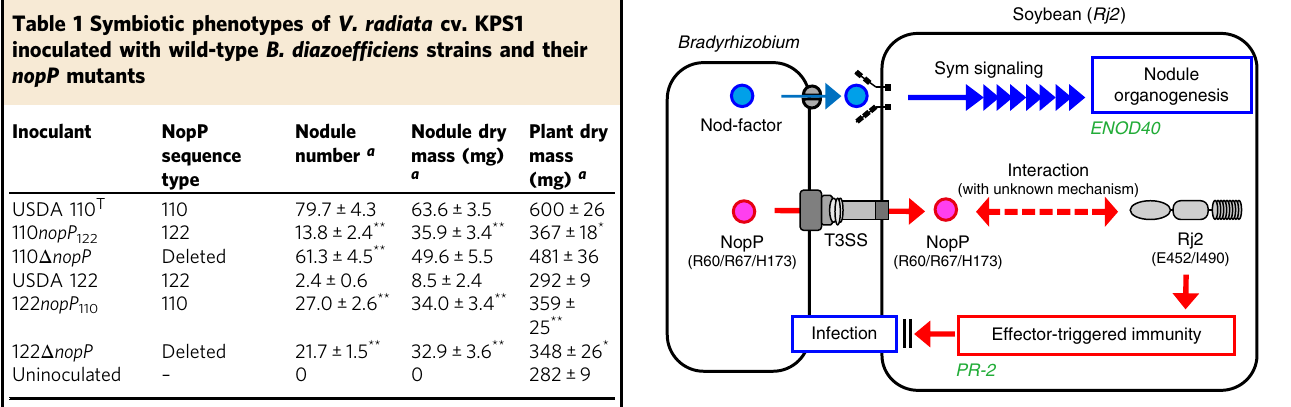
Fig. 9 Proposed molecular mechanism of Rj2 symbiotic